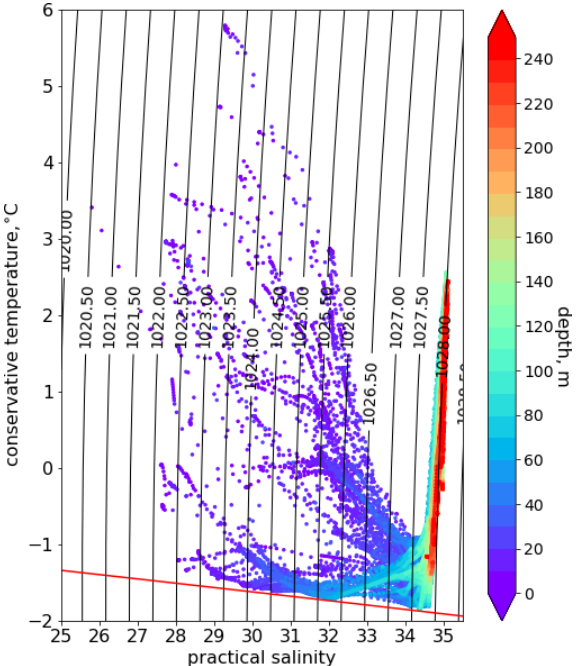
Figure 7. T – S diagram based on the CTD data in the upper 250m, color coded by depth. The red line shows the freezing